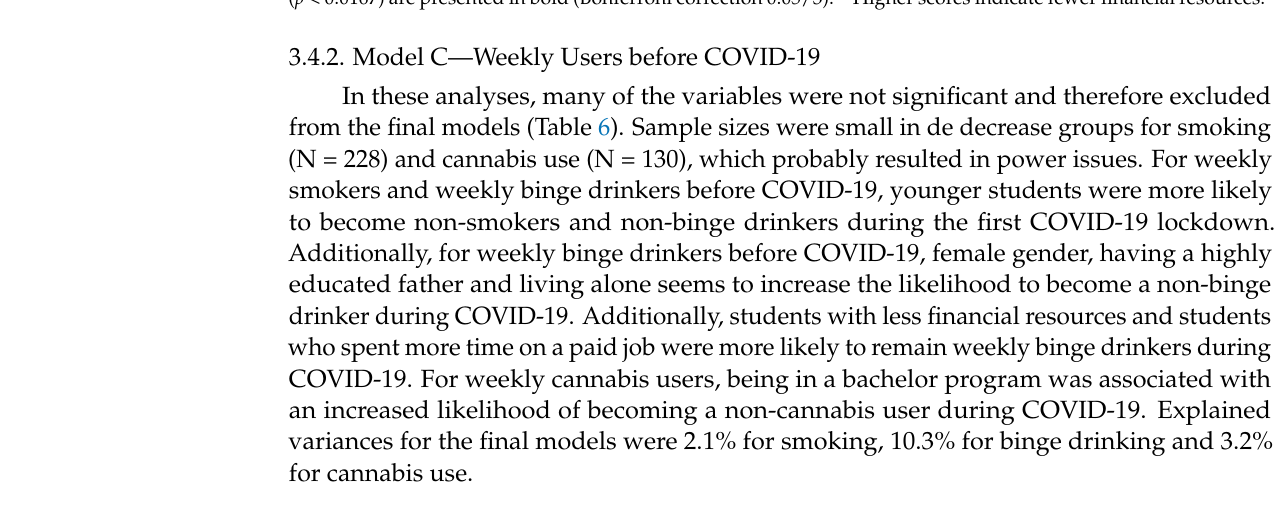
Table 6. Trends in substance use during the first COVID-19 lockdown in weekly users before COVID- 19: stable high vs. decrease (Model C) # . Smoking Stable High vs.